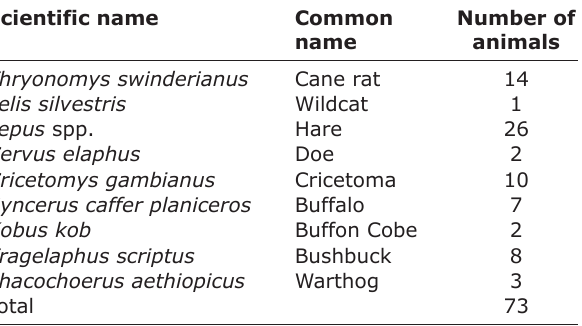
Table-1: The selected animal species.